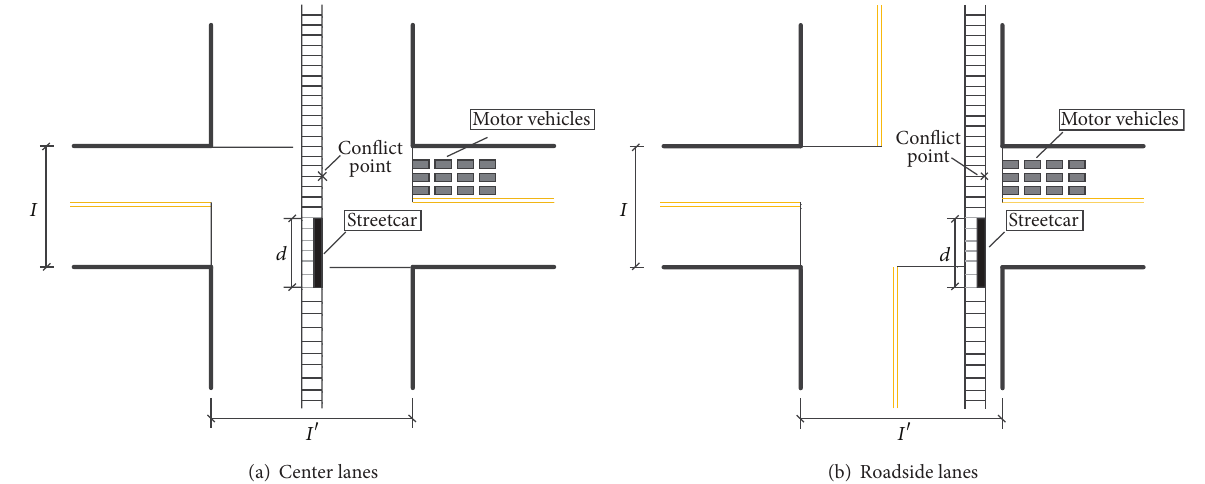
Figure 1: Track locations of modern streetcar